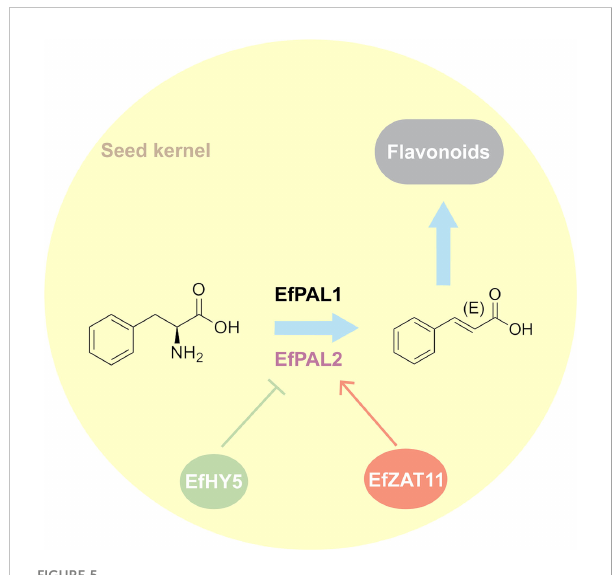
FIGURE 5 Hypothesized pattern of ZAT11 and HY5 mediating fl avonoid accumulation through regulation of PAL